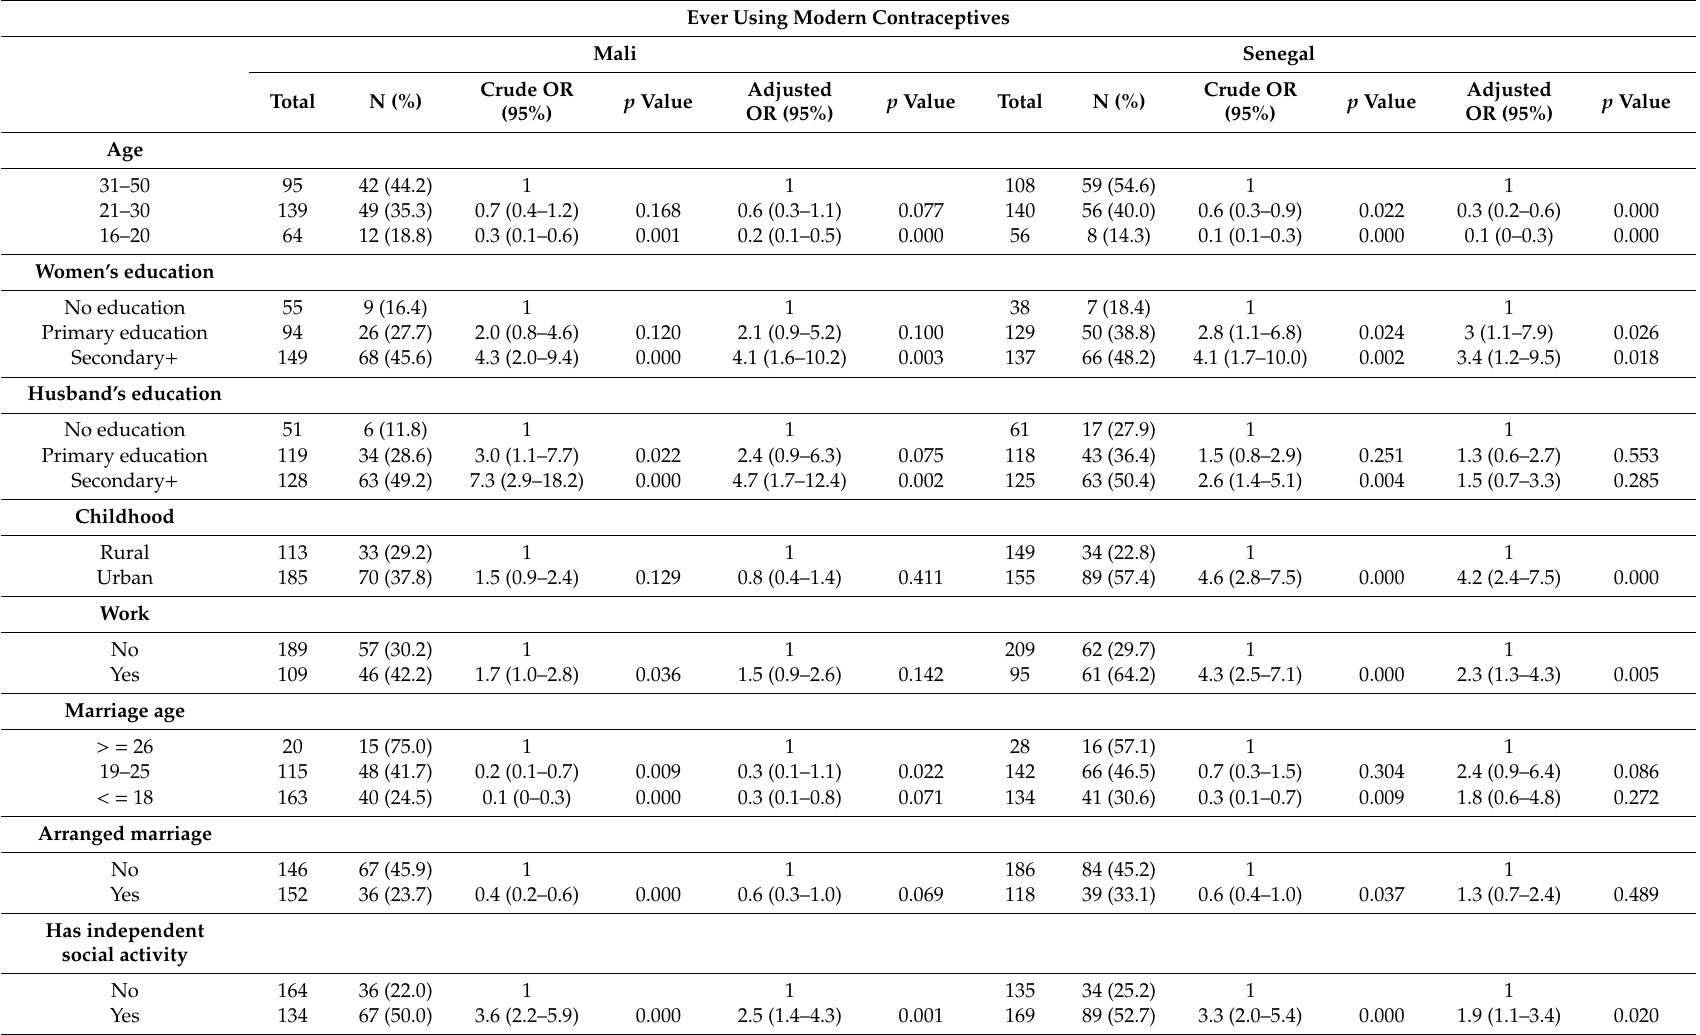
Table 4. Relationships between key variables and ever using contraceptives in Mali and